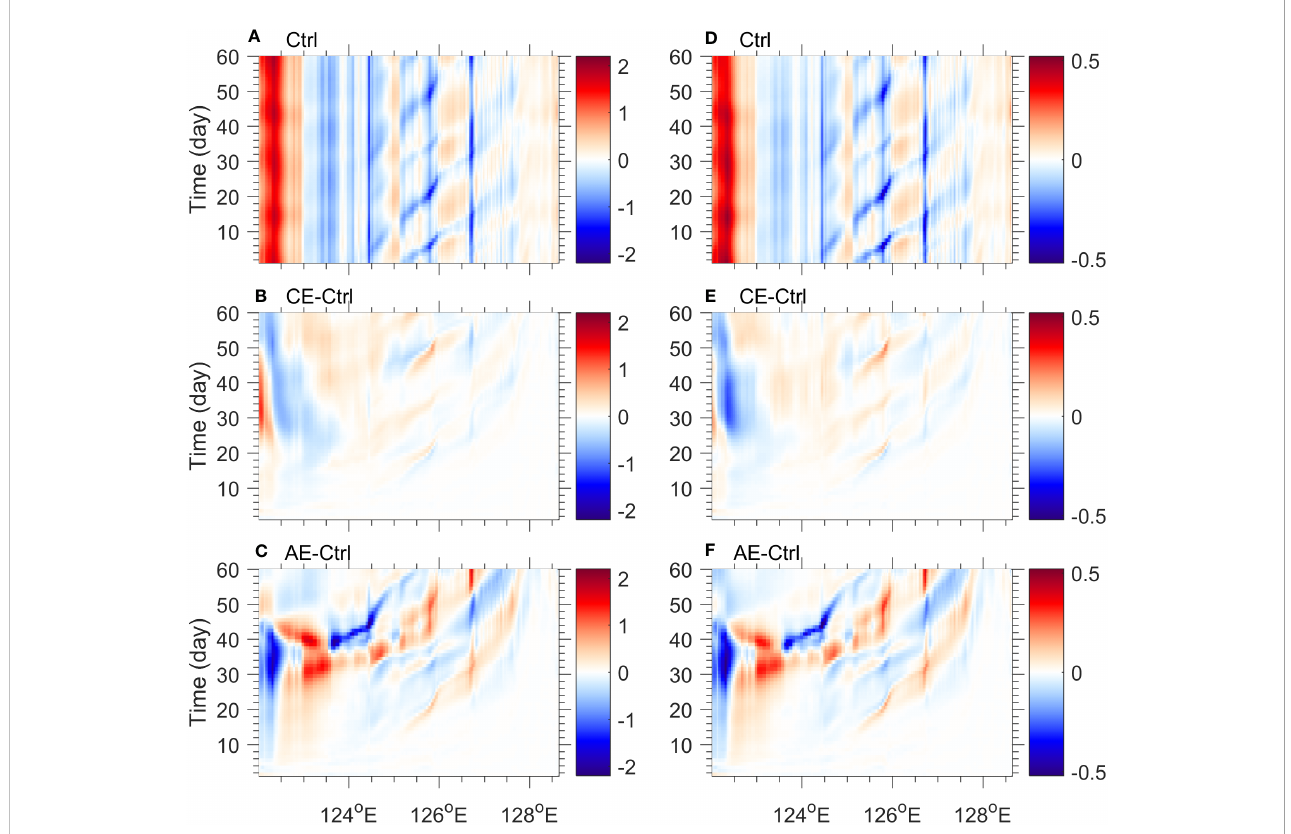
FIGURE 5 Vertical average (left panels) water (m 2 /s) and (right panels) phosphate (kg/ms) fl uxes along the 200 m isobaths from t=1 day to t=60 days in the (A, D) Ctrl experiment, and their variations under the effect of (B, E) cyclonic and (C, F) anticyclonic eddies. In Figures (A, D) the positive value indicates the onshore fl ux onto the ECS continental shelf, while the negative value indicates the offshore fl ux to the open